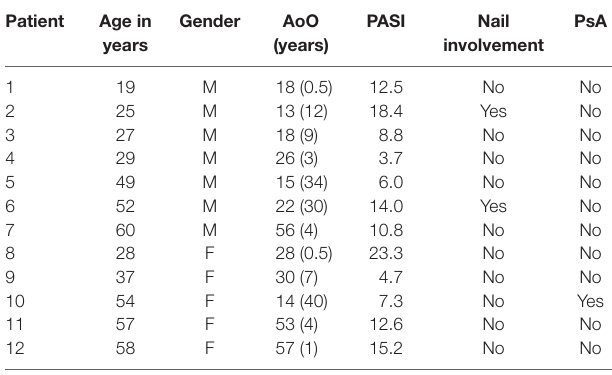
TaBle 1 | characteristics of the psoriasis